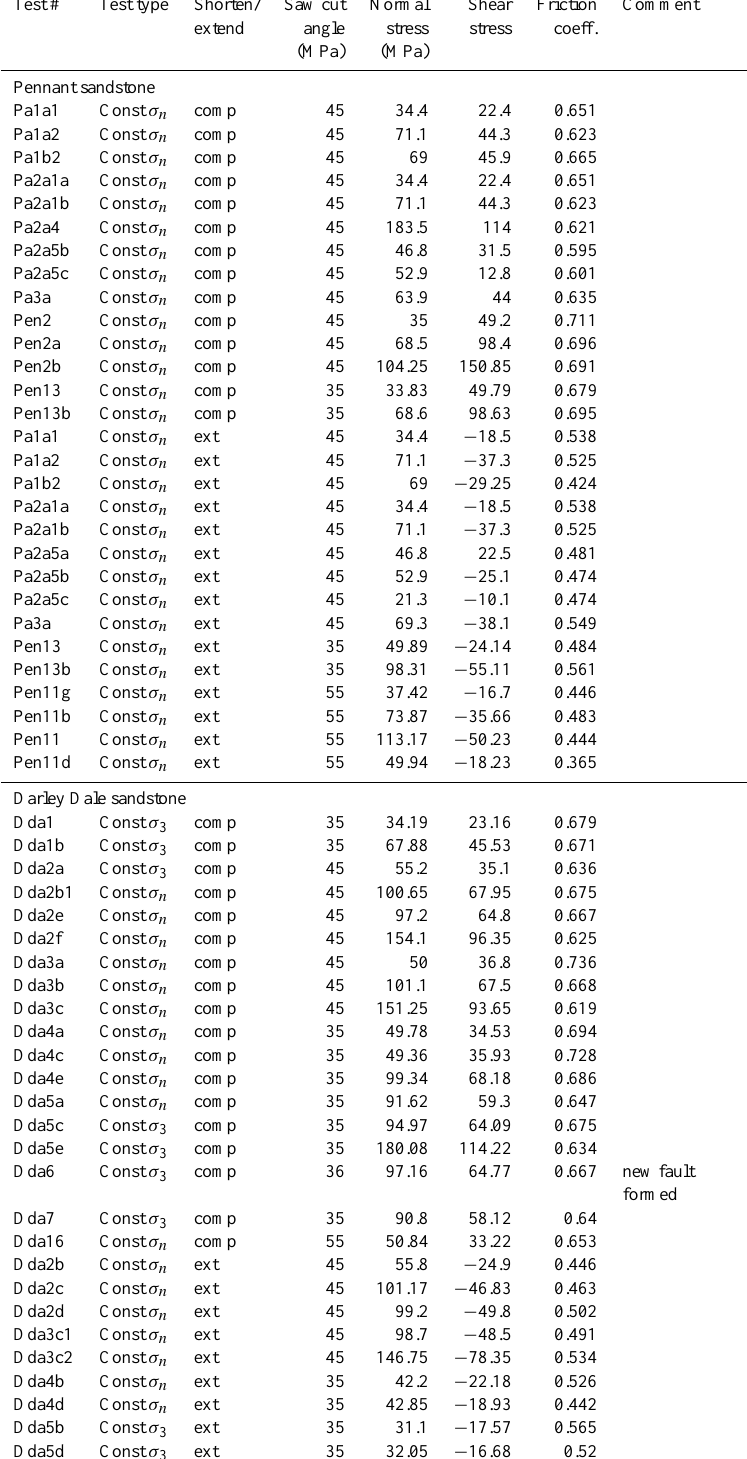
Table 2. Frictional sliding data and saw cut specimens, with an axial displacement rate = 0.05mmmin − 1 . All tests displayed stable sliding. Saw cut angle is measured from cylinder axis. Shear stresses are negative in